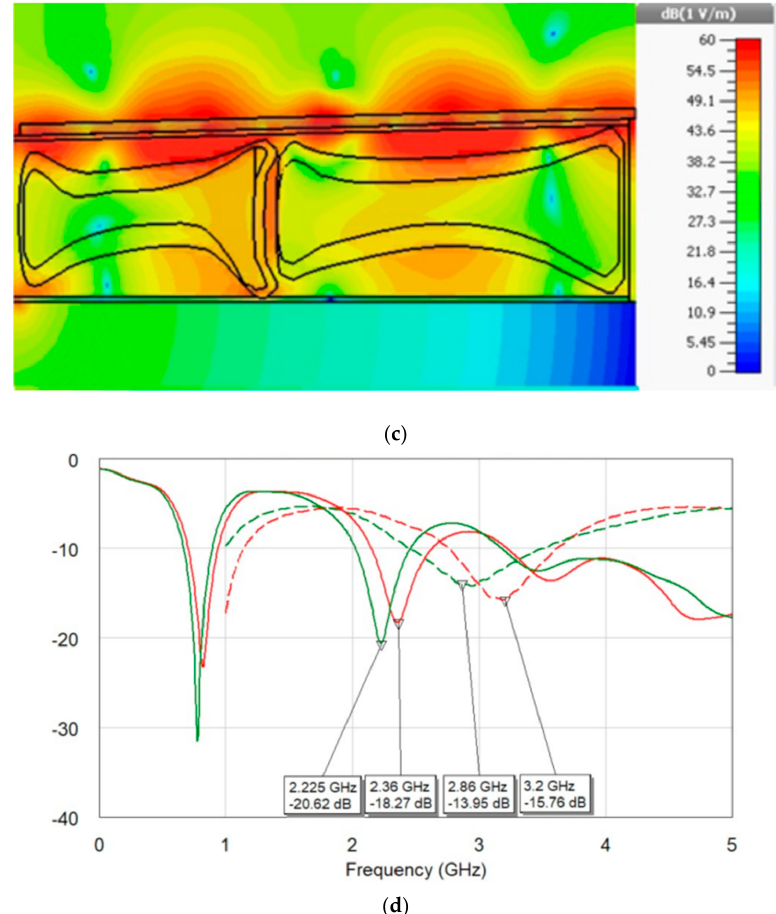
Figure 12. ( a ) Electric field distribution in the finger excited by the printed antenna: printed antenna placed on top of the finger, ( b ) electric field distribution inside the modeled tissues at 750 MHz and ( c ) at 2225 MHz; ( d ) return loss of the antenna: red curves—diseased bone, green curves—healthy bone, solid lines—modeling, and dashed lines—experiment The printed antenna with dimensions of 5.5 × 0.35 cm was manufactured and tested